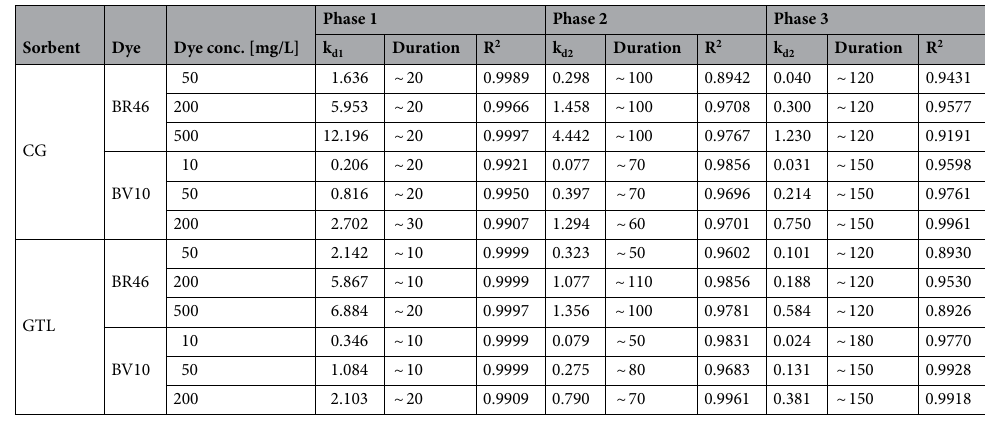
Table 3. Rate constants of BR46 and BV10 diffusion determined from a simplified intramolecular diffusion model. Units: k